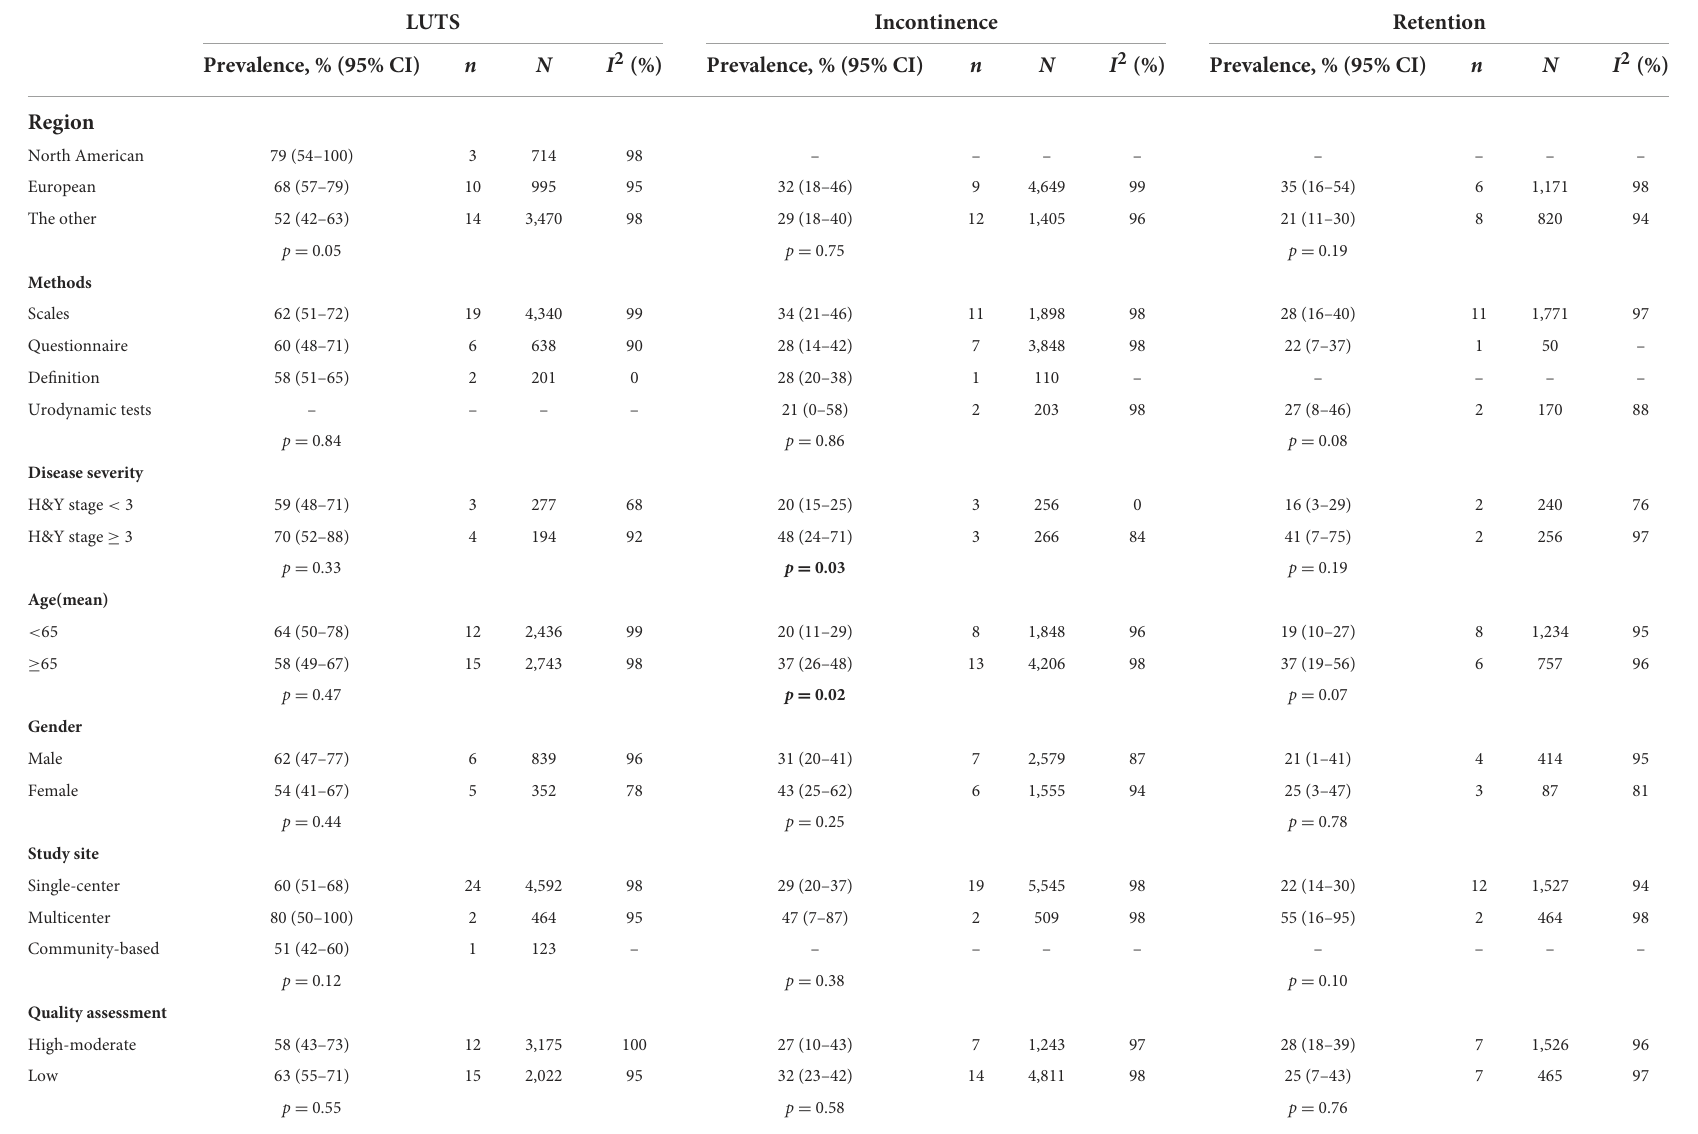
TABLE 2 Prevalence of LUTS or subtypes: results of the subgroup analysis. Subgroup prevalence, % (95% CI), n studies, N number, I